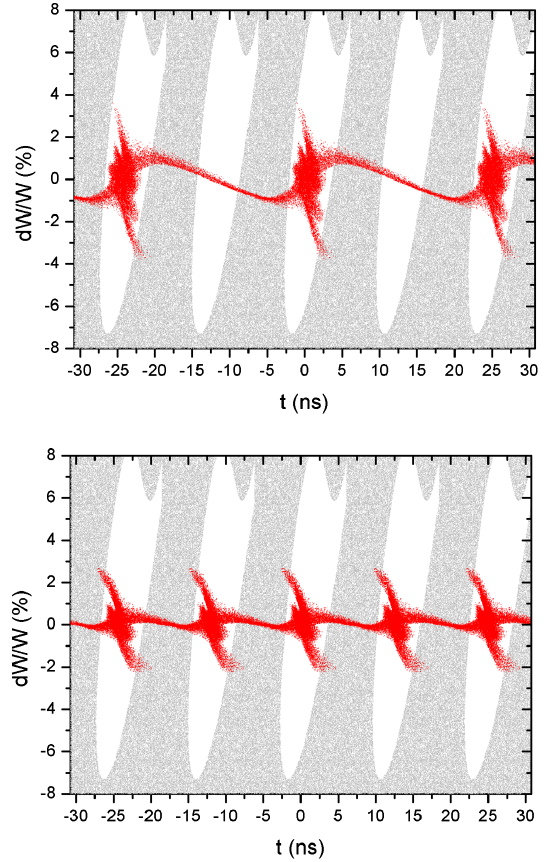
FIG. 34. Simulated beam longitudinal distributions after being bunched by a three-harmonic buncher (up) and a two-harmonic buncher (down) for a 1.6 emA U 35 þ beam.